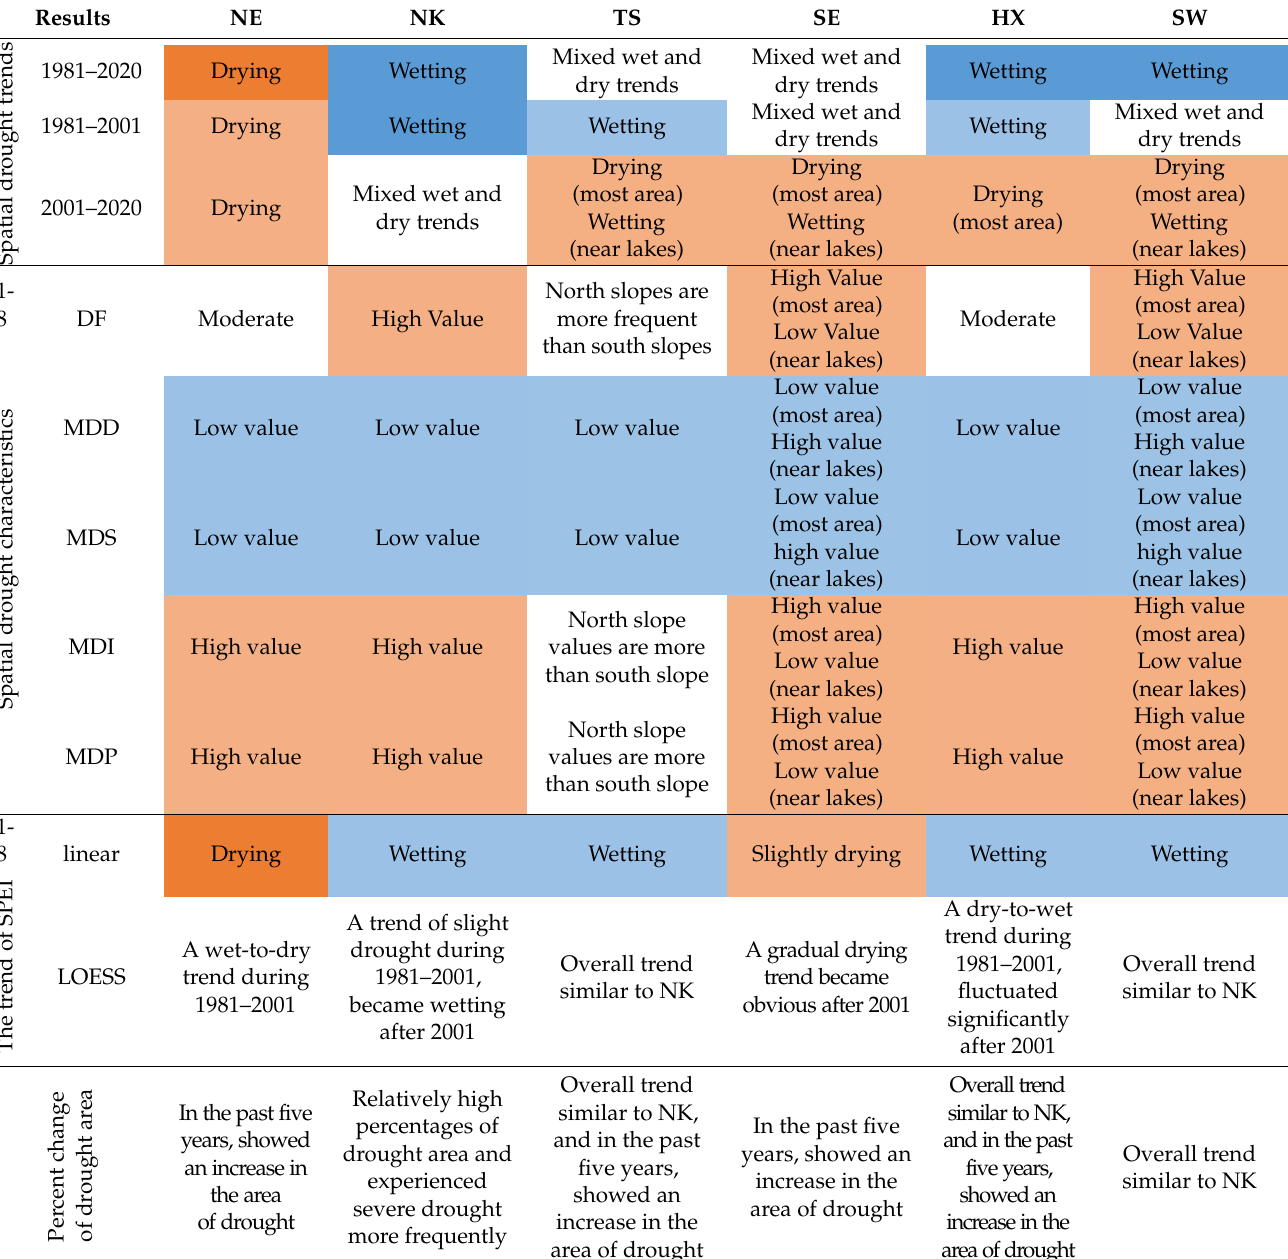
Table 2. Spatiotemporal characteristics of drought at a sub-regional